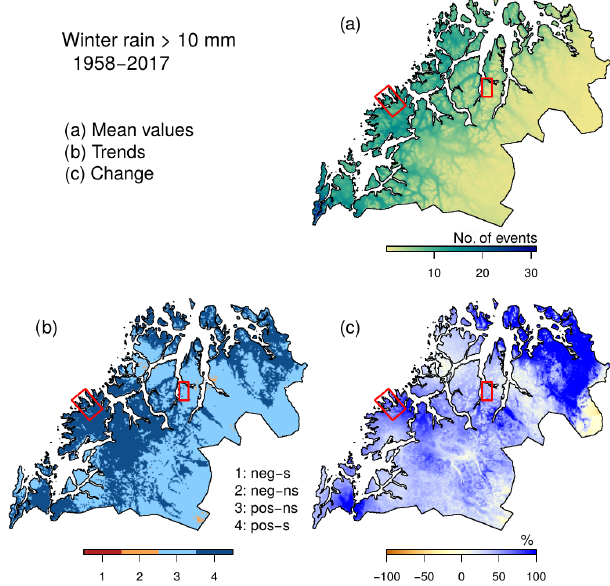
Figure 12. Frequency of zero crossings during winter (October– April) for the period 1958–2017, based on minimum and maxi- mum daily temperature. Mean values (a) , trends (b) and changes are shown in the same way as in Fig. 4.